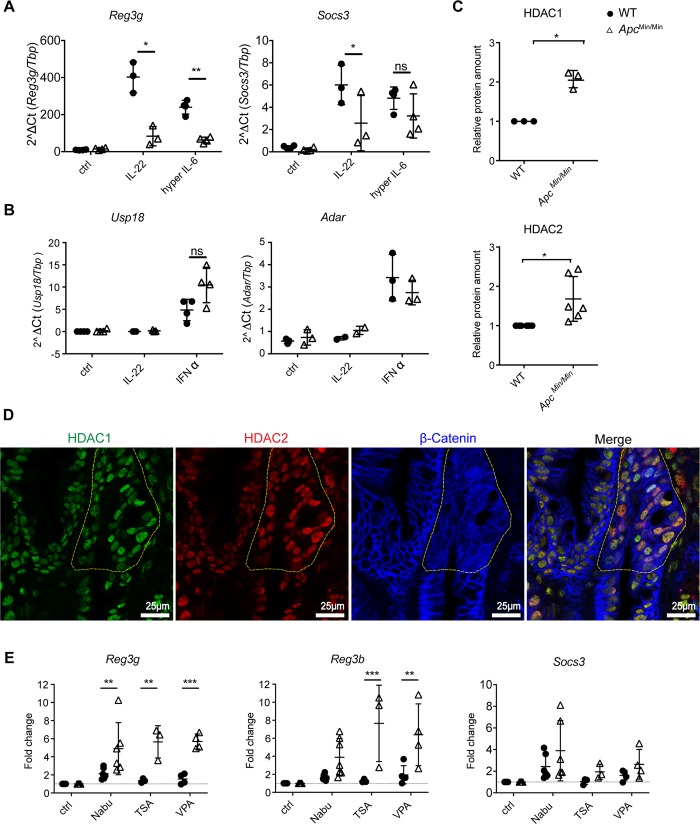
HDAC inhibition partially rescues STAT3-mediated gene transcription in ApcMin/Min organoids.(A) RT-qPCR analysis of WT and ApcMin/Min organoids treated with IL-22 (10 ng/ml) or hyper IL-6 (50 μM) for 3 hours. Data show mRNA expression of STAT3 target genes, Reg3g or Socs3, relative to Tbp. (B) RT-qPCR analysis for WT and ApcMin/Min organoids treated with IL-22 (10 ng/ml) or IFNα (1,000 U/ml) for 3 hours. Data show the expression of STAT1 target genes, Adar and Usp18 relative to Tbp. At least 3 independent experiments were performed. *p < 0.05, **p < 0.01, paired t test. (C) Western blot analysis of proteins in WT and ApcMin/Min organoids. Expression of HDAC1 and HDAC2 was normalized to loading control, STAT3, in each sample and expressed relative to that in WT organoids. (D) ApcMin/+ mouse small intestine was fixed and stained with antibodies against HDAC1, HDAC2, and β-catenin. Nuclei were visualised with DAPI. ApcMin/Min small intestinal polyps (marked by yellow dotted line) were defined by diffuse and increased β-catenin staining. (E) WT and ApcMin/Min organoids were treated with NaBu (10 mM), TSA (50 nM), or VPA (1 mM) for 16 hours and then stimulated with IL-22 (10 ng/ml) for 3 hours. RT-qPCR was performed. Data show the expression of Reg3g, Reg3b, and Socs3 relative to the IL-22–stimulated control in each genotype. **p < 0.01, ***p < 0.005, Two-way ANOVA, with Sidak’s multiple comparison. At least 4 independent experiments were performed. Numerical values for (A), (B), (C), and (E) are available in S1 Data. Adar, Adenosine deaminase RNA specific; Apc, adenomatous polyposis coli; HDAC, histone deacetylase; IFN, interferon; IL-22, interleukin-22; NaBu, sodium butyrate; ns, not significant; RT-qPCR, quantitative reverse transcription polymerase chain reaction; Reg3g, regenerated islet-derived protein 3 gamma; Reg3b, regenerated islet-derived protein 3 beta; Socs3, Suppressor of cytokine signalling 3; STAT3, signal transducer and activator of transcription 3; TSA, Trichostatin A; Usp18, ubiquitin specific peptidase 18; VPA, valproic acid; WT, wild-type.